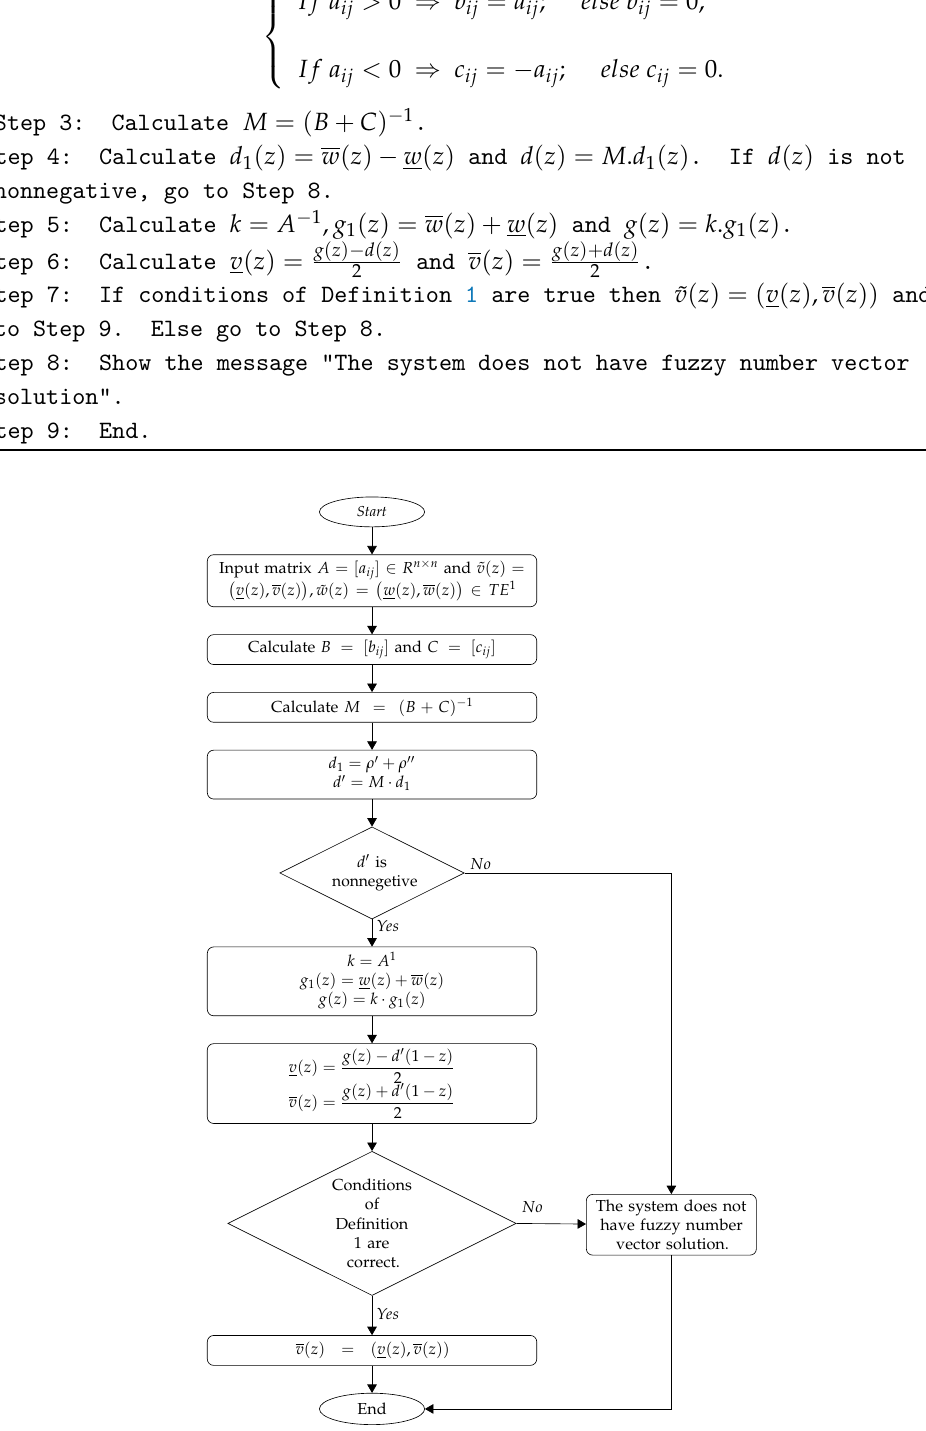
Figure2. FlowchartofAlgorithm2. Figure 2. Flowchart of Algorithm